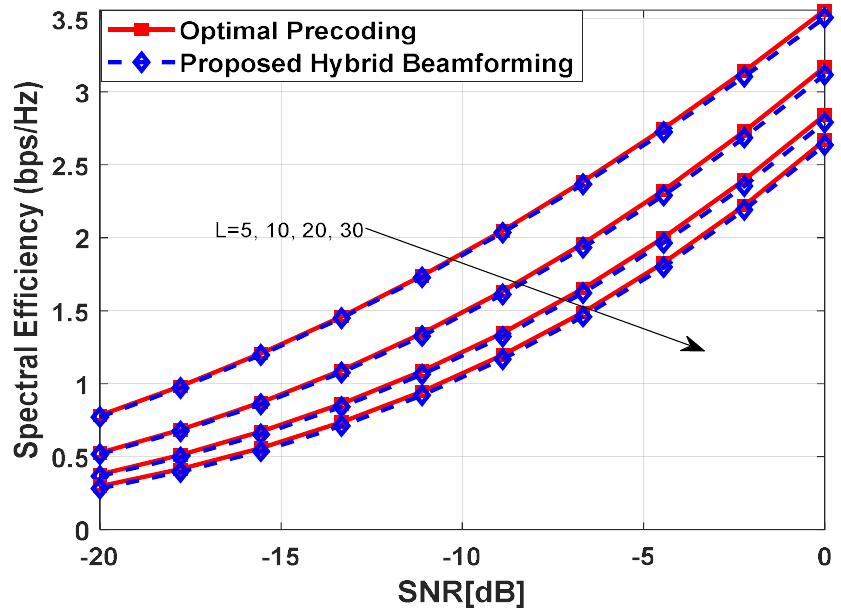
Figure 5. Spectral Efficiency vs. SNR at L = [ 5, 10, 20, 30 ] when N t = N rel = 64, N r = 16, N s = 4 = N RF = N RF = N s with ULA and N RF r t rel